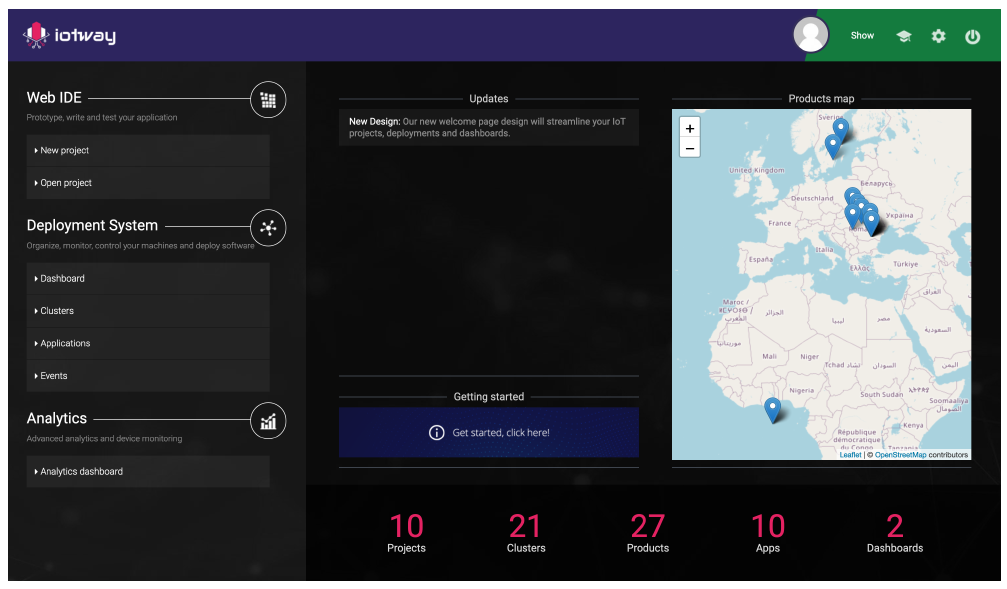
Figure 7. IoTWay